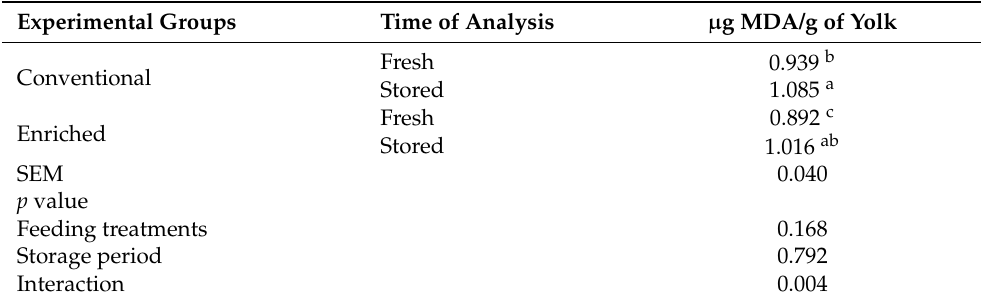
Table 8. Lipid oxidation in egg